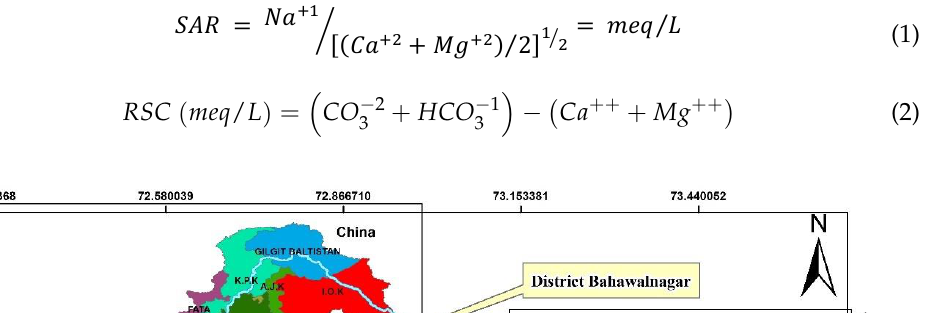
4 of 16 Figure 1. GIS locations of water sampling and cotton yield studied area. 2.3. Analysis of Samples Collected samples were taken to the Soil and Water Testing Laboratory Bahawalpur for analysis. For the determination of the pH of water samples, a pH meter (pH 200 Senso- direct) and for the electric conductivity (EC), a conductivity meter (CON200 Senso-direct, Lovibond, Tintometer GmbH, Dortmund, Deutschland) was used by following the stand-